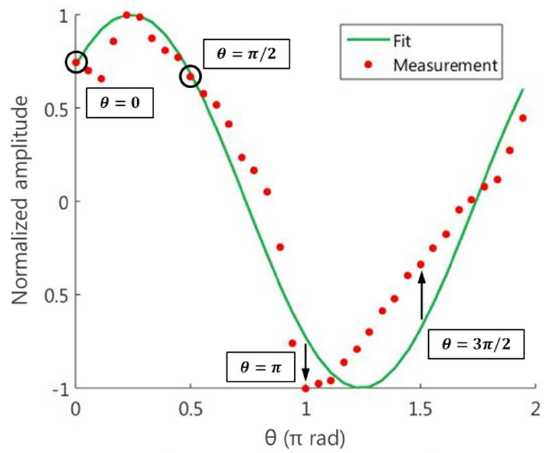
Figure 8. Relative phase measurements of the LP 21e mode together with its cosine least-squares best fit, based on Equation (18), for the transversal intensity distribution shown in Figure 2b. Superimposed to the graph in Figure 8, four points have been highlighted. First, two points, θ = 0 and θ = π/2, are the particular cases from Equations (8) and (9). In this case, the points show a good agreement with the fitting curve. In fact, following the two-measurements procedure, a phase difference of 0.23π rad is obtained, which is al- most the same value as the one determined through the fitting approach: 0.24π rad.